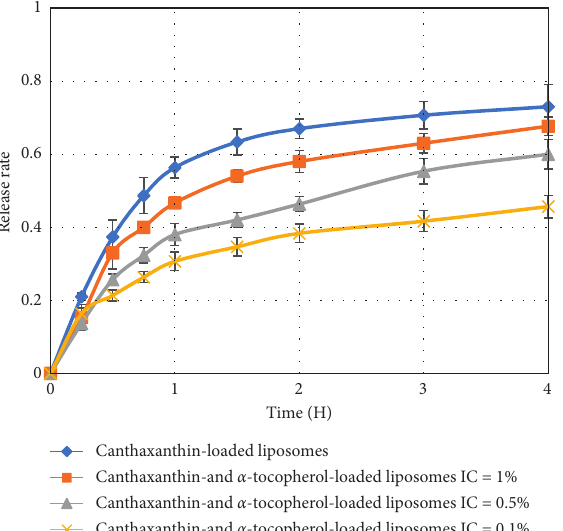
Figure 4: In vitro release profile of canthaxanthin from canthaxanthin-loaded liposomes, canthaxanthin- and α -tocopherol-loaded li- posomes with IC � 0.1%, canthaxanthin- and α -tocopherol-loaded liposomes with IC � 0.5%, and canthaxanthin- and α -tocopherol-loaded liposomes with IC � 1% in PBS at pH 7.4.